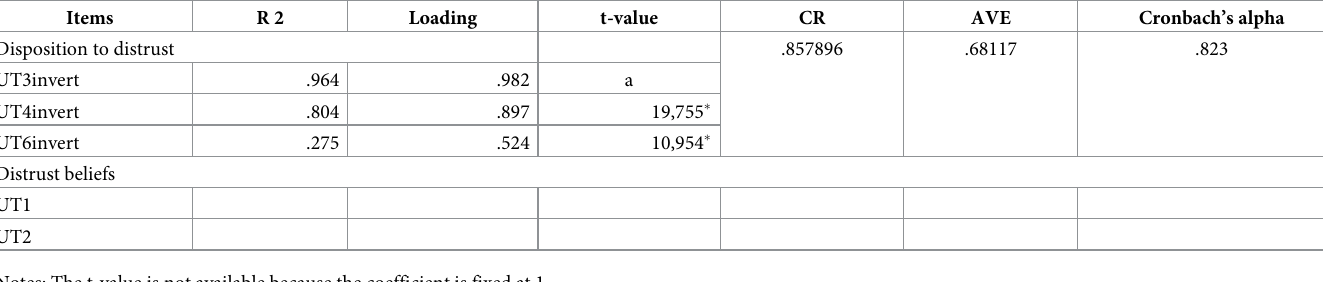
Table 13. The reliability statistics for the distrust scale (obtained from confirmatory factor analysis). Items R 2